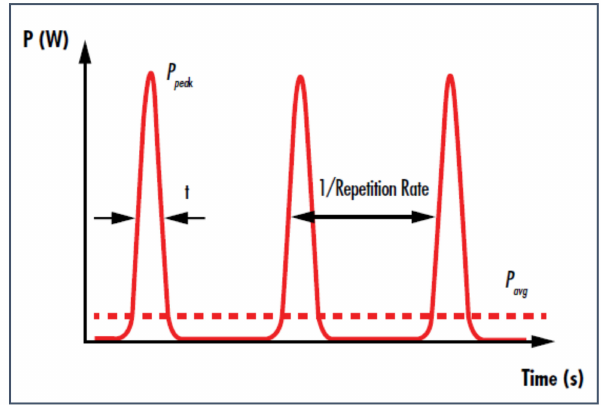
Figure 9. Illustration of the pulse repetition rate of a laser